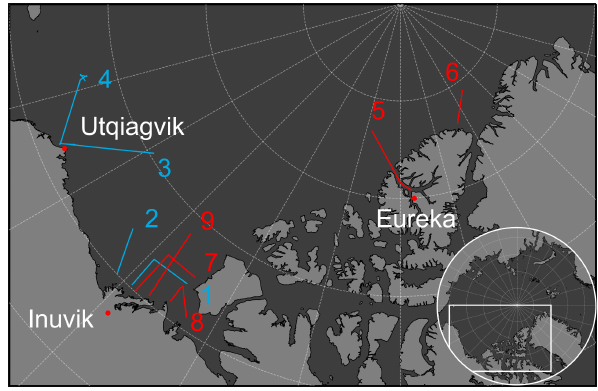
Figure 2. IceBird surveys in 2017 (blue) and 2019 (red) in the focus of this study. The numbering corresponds to the individual surveys listed in Table